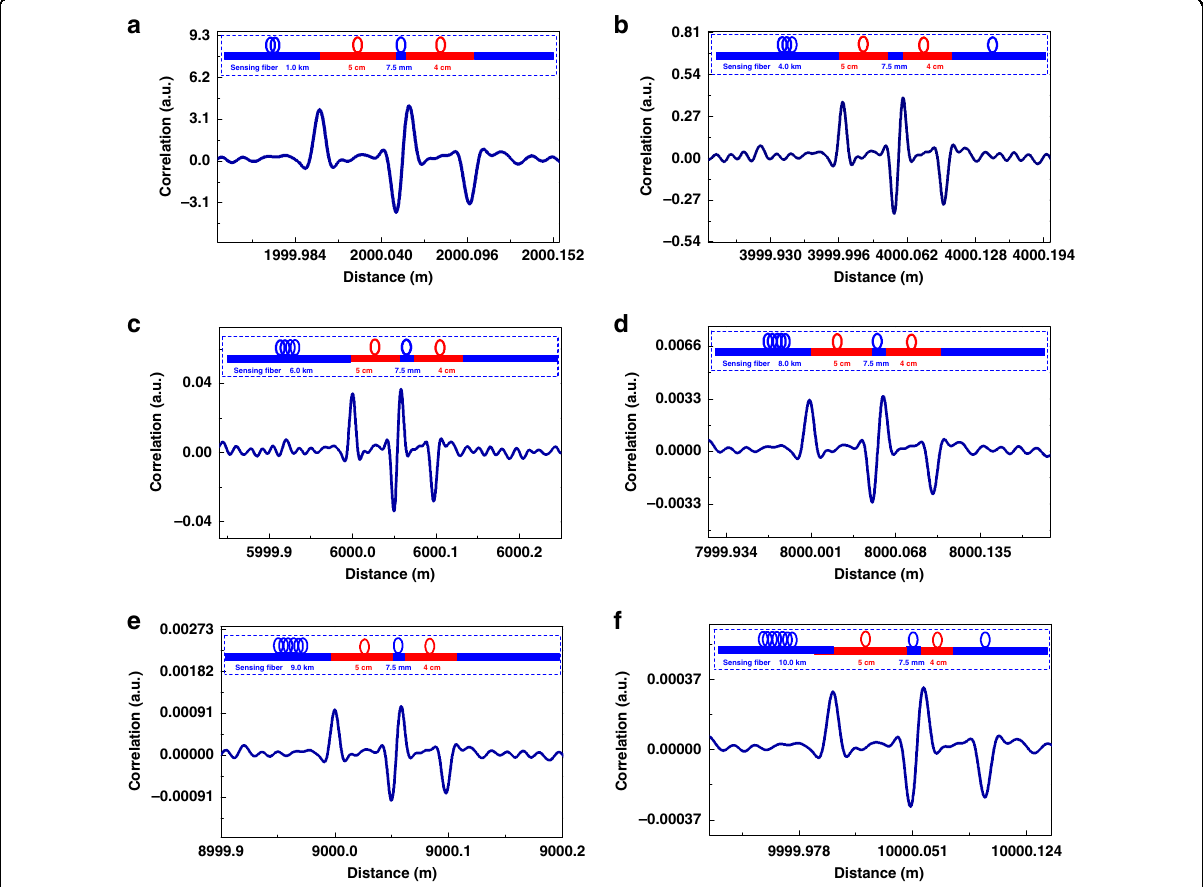
Fig. 10 Spatial resolution results based on compression correlation demodulation 54 . a 2.0 km ( b ) 4.0 km ( c ) 6.0 km ( d ) 8.0 km ( e ) 9.0 km ( f ) 10.0 km. Reprinted with permission from ref. 54 , © 2021 The Authors. Advanced Photonics Research published by Wiley-VCH